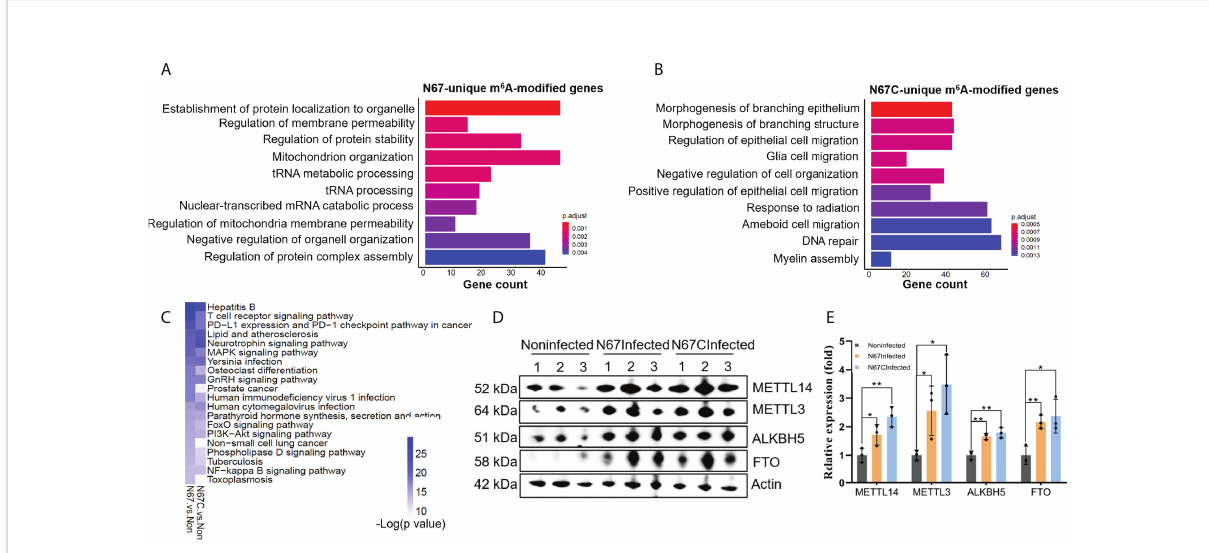
FIGURE 5 Strain-speci fi c immune response pathways regulated by m 6 A modi fi cations. (A) Biological processes of 733 N67-unique m 6 A-modi fi ed genes. Shown are the top 10 enriched pathways. (B) Biological processes of 1436 N67C-unique m 6 A-modi fi ed genes. Shown are the top 10 enriched pathways. (C) KEGG overlapping pathways of genes gained m 6 A peaks post malaria infections. Shown are the top twenty enriched pathways with low p-value for N67/noninfected and N67C/noninfected comparisons. (D) Western blots showing expression levels of m 6 A writer proteins METTL3, METTL14, and eraser proteins FTO, ALKBH5 in spleens of N67-, N67C-infected or noninfected mice. (E) Relative expression levels of m 6 A methylation machinery proteins. Signal intensity relative to b -actin was determined using Image (J). Values are the means±SD, n =3. * P < 0.05, ** P < 0.01, Student ’ s t